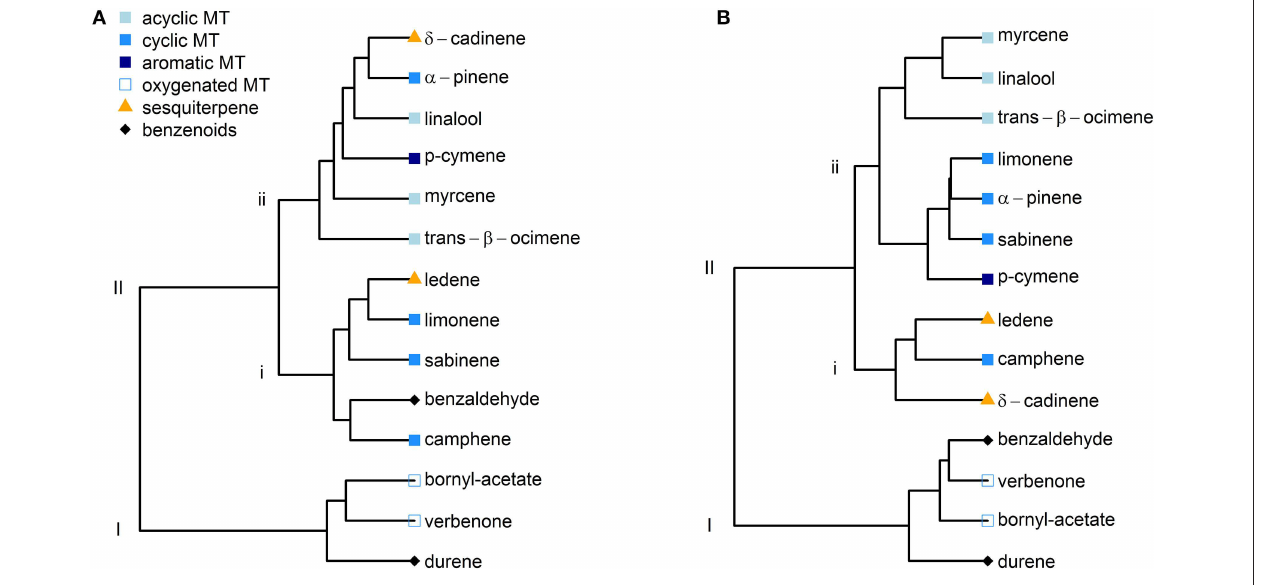
FIGURE 4 | Hierarchical clustering of selected BVOCs according to their δ 13 C value independent of the species for June (A) and July (B) . BVOCs were sorted according to their chemical structure into acyclic monoterpenoids (square, lightblue), cyclic monoterpenes (square, blue), aromatic monoterpenes (square, darkblue), oxygenated monoterpenoids (square, blue edge), sesquiterpenes (triangle, orange), and benzenoids (diamond,